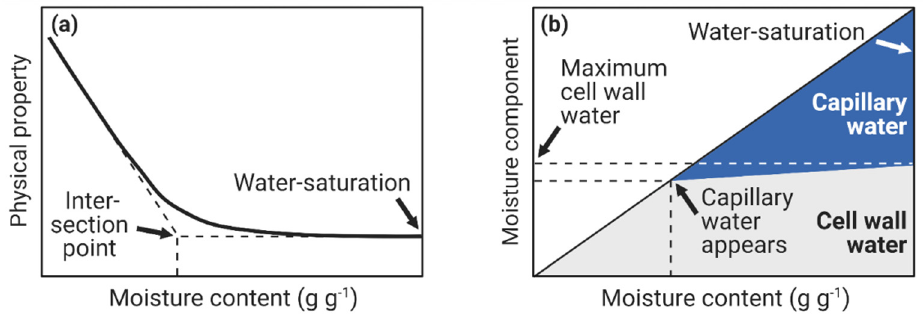
Figure 4. Different moisture states related to literature definitions of the fiber saturation point (FSP) from ( a ) the measurement of the physical property and ( b ) the partitioning of the water in wood into capillary water and cell wall water. In ( a ) FSP is defined as the moisture content at the intersection point of the two linear regimes, whereas in ( b ) FSP is defined as the maximum cell wall moisture content or as the moisture state where capillary water appears. Note that the various definitions do not refer to the same moisture state of the wood.